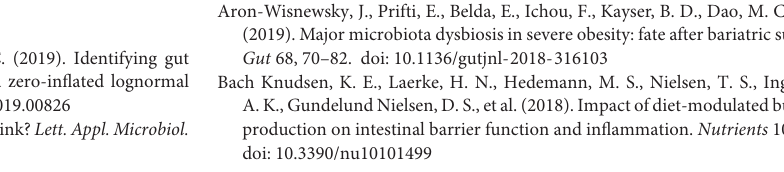
Supplementary Figure 3 | Average daily feed intake per mouse over the experimental period. Supplementary Figure 4 | Levels of fluorescein isocyanate (FITC)–dextran in sera samples of each group after intragastric injecting FITC–dextran tracer. The FITC–dextran tracer (0.6 mg/g body weight) was dissolved in 0.1 ml of phosphate-buffered saline. The blood level of FITC-dextran was monitored in triplicate by measuring the intensity value of FITC fluorescence in sera samples at an excitation wavelength of 490 nm and an emission wavelength of 530 nm to investigate the degree of gut permeability in mice. Supplementary Figure 5 | Fold changes in the gene expression of markers detecting the enteropathogenic Escherichia coli (intimin) (A) , Lactobacillus spp. (B) , and Bifidobacterium spp. (C) in samples of intestinal contents by group. All samples were measured in triplicate. Detailed sequence information for each marker is listed in Supplementary Table 1 . Supplementary Figure 6 | Differences in the gut microbial diversity among groups upon pro-/synbiotics treatment. Alpha diversity indices ( A: Shannon index; B: Simpson index) of gut microbiota by group. Effects of phthalyl pullulan nanoparticle (PPN) treatment on observed operational taxonomic units (OTUs) (C) . All alpha diversity indices were investigated using QIIME version 1.9.1 software. Supplementary Figure 7 | Relative abundance of Proteobacteria by group. One-way ANOVA with Tukey’s post hoc test was used to determine significant differences among groups, and different superscript letters indicate a significant difference ( p < 0.05). Supplementary Figure 8 | Overall compositions of the gut microbiota at the genus level (A) and relative abundance of genera significantly differed by group. (B) One-way ANOVA with Tukey’s post hoc test was used for each genus to determine significant differences among groups, and different superscript letters indicate a significant difference ( p < 0.05). Supplementary Figure 9 | Metagenomic prediction of gut microbiota of dysbiosis-induced mice after the trial to determine the effects of synbiotics LP/phthalyl pullulan nanoparticles (LP/PPN) ( A ; T1 vs. T4, linear discriminant analysis (LDA) score > 3.0) or prebiotics nanoparticulation ( B ; T3 vs. T4, LDA score > 2.0). Microbial functions were predicted using PICRUSt at the third level of the KEGG pathway, and LEfSe analysis was represented as histograms. Supplementary Figure 10 | Correlation analysis between the level of serum endotoxin and relative abundance of bacteria. Proteobacteria (A) was the only phylum that showed a correlation with serum endotoxin. Several genera, including Cronobacter (B) , unclassified genus of the Enterobacteriaceae family (C) , Enterobacter (D) , and Streptococcus (E) , were significantly positively correlated, whereas Lactobacillus (F) was significantly negatively correlated with the level of serum endotoxin. The relationship was assessed by Pearson’s correlation coefficient (r) and p -values from simple linear regression. Supplementary Table 1 | Primer sequences to identify specific bacteria [ Escherichia coli ( intimin ), Lactobacillus spp., Bifidobacterium spp., and 16S rRNA ( B16S )] were used to conduct quantitative polymerase chain reaction (qPCR) with gDNA of intestinal contents. Supplementary Table 2 | Relative abundance of phyla and genera of the mouse ceca microbiota and all-sharing taxon upon pro-/synbiotics treatment. Data are shown as mean ± SD rounded off to the third digit after the decimal point. One-way ANOVA with Tukey’s post hoc test was used to determine significant differences among groups. Different superscript letters indicate statistical significance ( p <